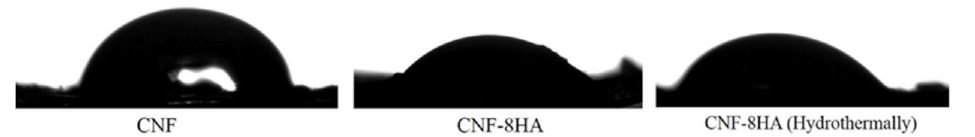
Figure 2. Contact angle of the prepared carbon nanofibrous scaffoldswas measured (n = 5) for each sample. The contact angles were 76 ± 0.05 ◦ , 53 ± 0.19 ◦ , 49 ± 2 ◦ for CNF, CNF-8HA, and CNF-8HA (H).